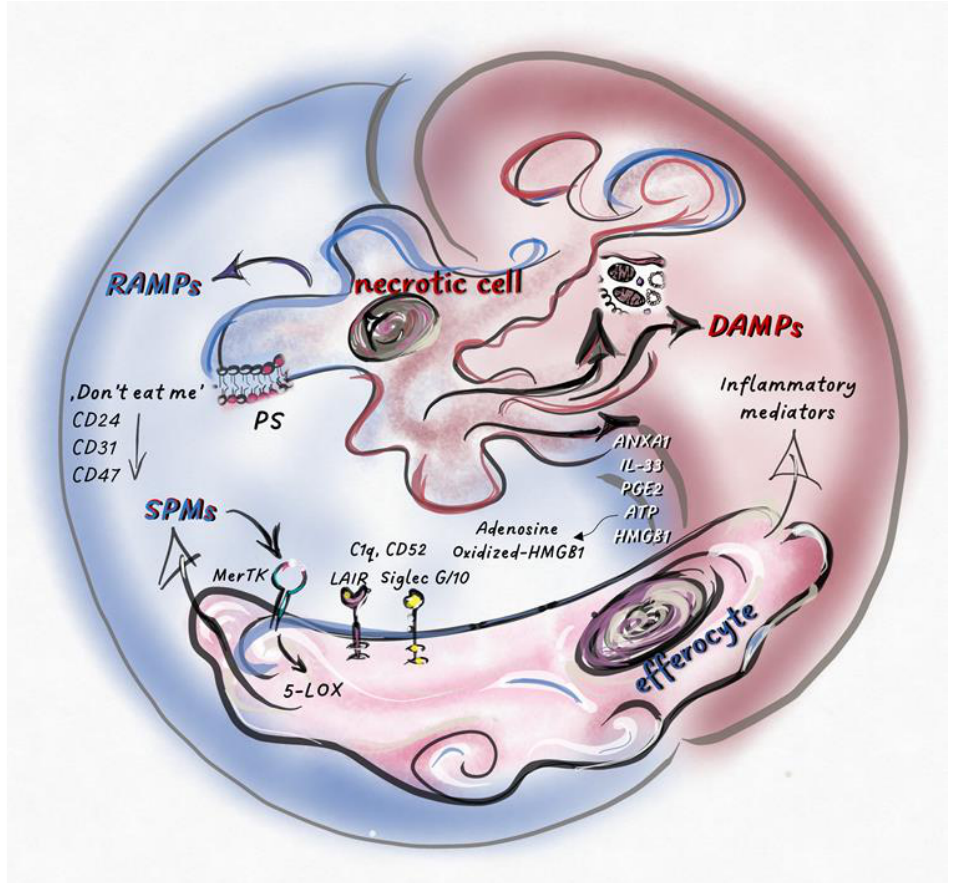
Figure 2. Necrotic cell death regulates the balance between pro-inflammatory- and pro-resolution- signals inducing necro-inflammation or necro-resolution.Intracellular molecules and molecular pat- terns associated with damage and resolution (DAMPs and RAMPs) are released from necrotic cells. Various cell types and their inflammatory or anti-inflammatory subpopulations sense these secreted mediators, together with dead cell corps in the tissue environment. Here, pro-inflammatory or pro- resolution mediators, such as SPMs, become dominant, which is determined by the type of cell death and the cells that sense it. Phosphatidylserine (PS) exposed on the surface of dying cells is recog- nized by MerTK receptors, stimulating the phosphorylation of 5-LOX in efferocytes and, conse- quently, increasing SP M production. “Don’t eat me” receptors (CD24, CD31, CD47) expressed by dying cells stimulate inhibitory receptors on efferocytes (such as Siglec 10), shifting the balance to- ward the anti-inflammatory response. The effects of the released factors could be modified by post- translational modifications or by the molecular partners interacting with them. After oxidation, HMGB1 loses its inflammatory potential, while its association with C1q, CD52, or CD24 results in its binding to inhibitory receptors (Siglec 10 or Leukocyte-associated immunoglobulin-like receptor 1 (LAIR1)), converting the effect of these complexes into anti-inflammatory. Extracellular ATP,